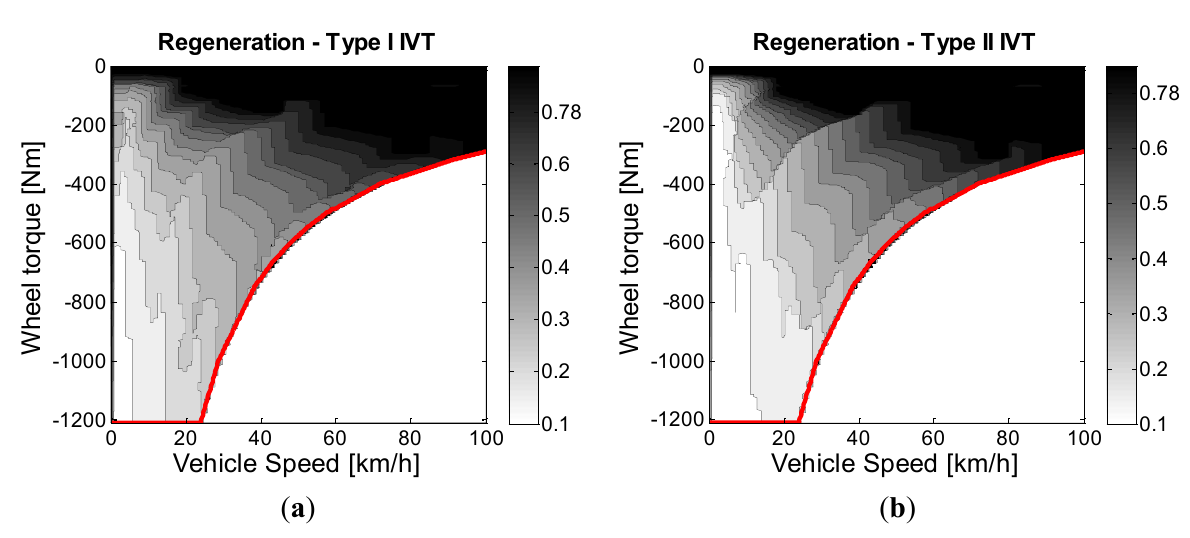
Figure 12. Regeneration driving chart for ( a ) Type I IVT and ( b ) Type II